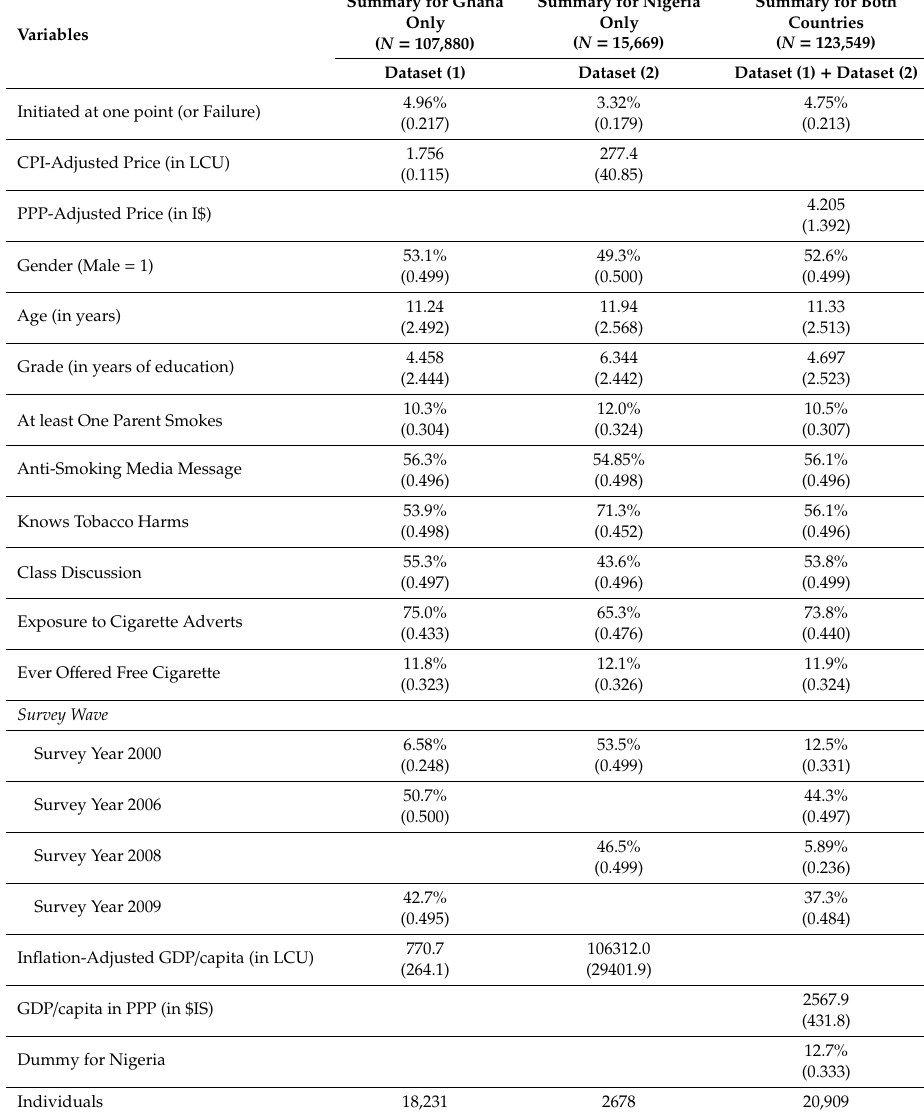
Table 3. Characteristics of youth (aged 8–18) in Ghana and Nigeria for a survival model of tobacco use initiation (standard deviations in